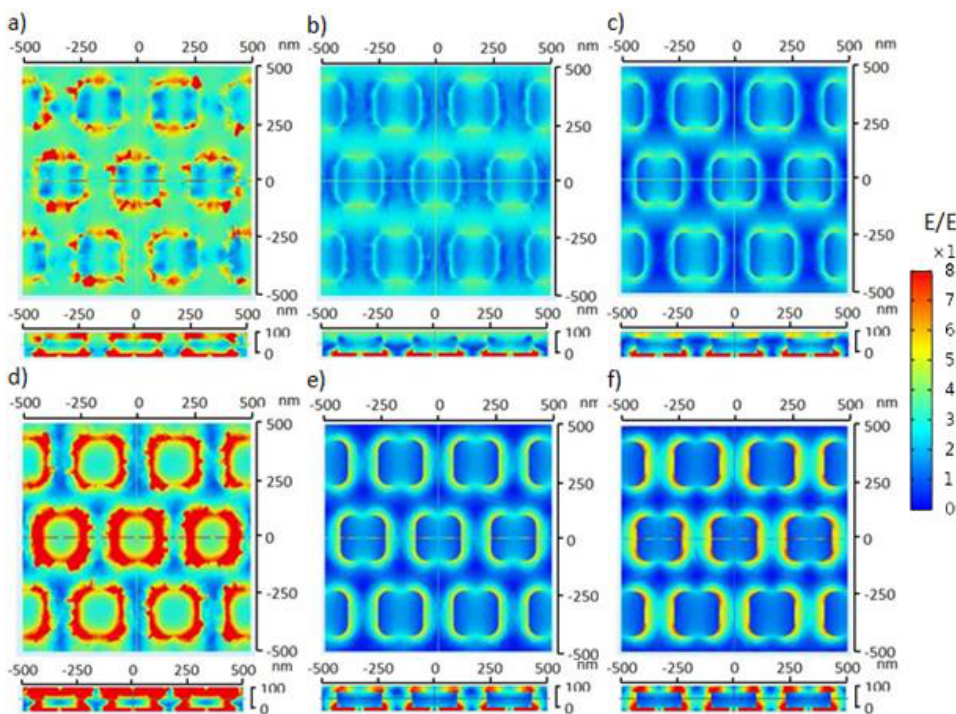
Figure 3. The top view and side view of the electric field distribution from the simulation results of Ag nanosquare arrays with a diameter of 250 nm irradiated with electromagnetic waves with wavelengths of ( a ) 500 nm, ( b ) 600 nm, ( c ) 700 nm, ( d ) 800 nm, ( e ) 900 nm, and ( f ) 1000 nm.